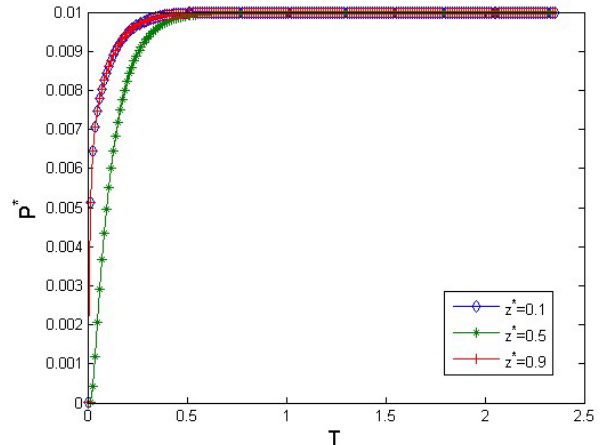
Figure 3. The dimensionless pore water pressure at different depths versus time.